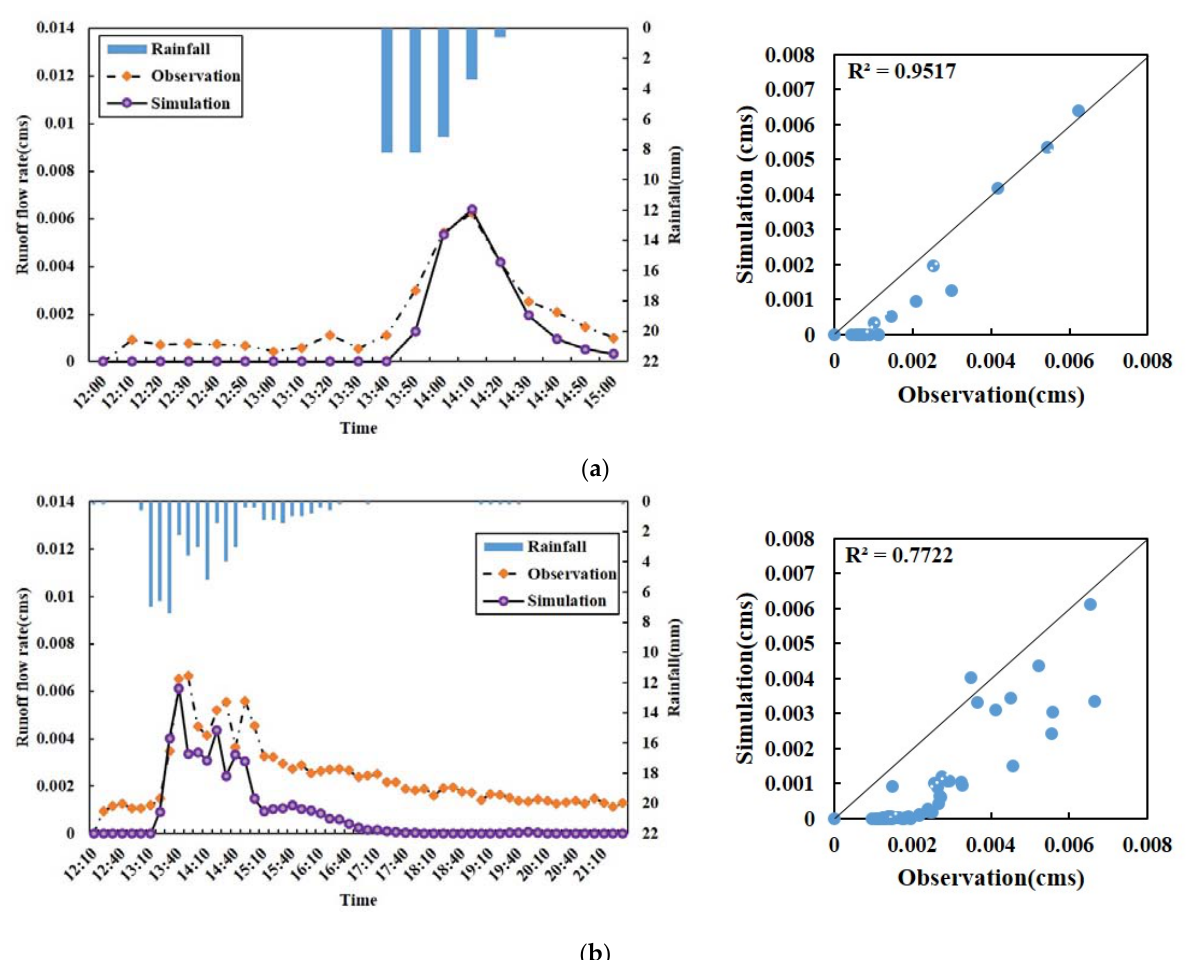
Figure 9. Comparison of observed and simulated runoff values using model-calibrated parameters: ( a ) calibration; ( b ) validation.